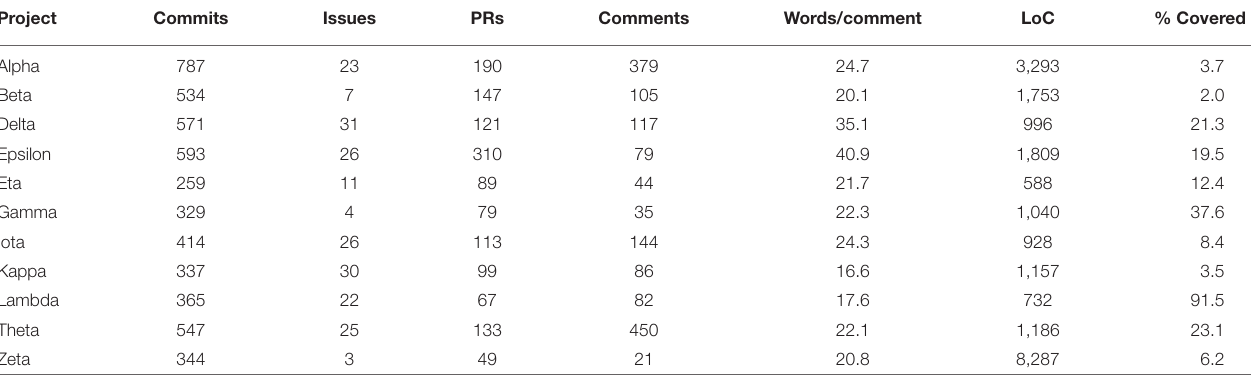
TABLE 2 | GitHub and other code metrics for student projects.